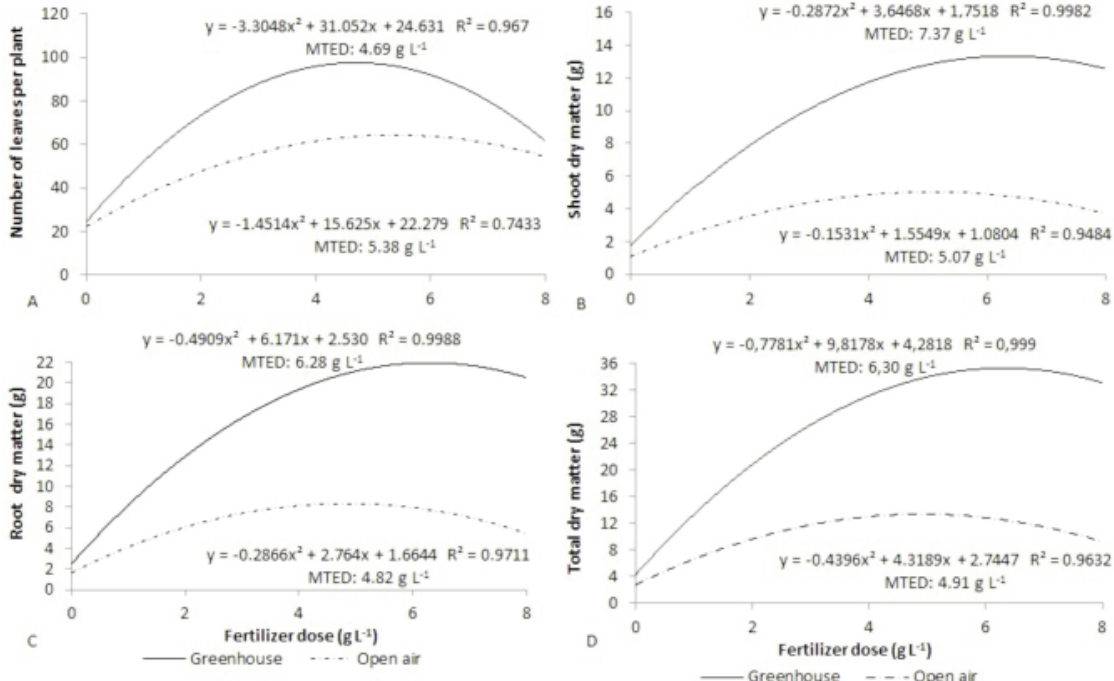
Fig. 3 ­ Number of leaves per plant (3A), shoot dry mass (3B), root dry mass (3C) and total dry mass (3D) of peach plants cv. Capdeboscq, in relation to the dosage of CRF and two cultivation